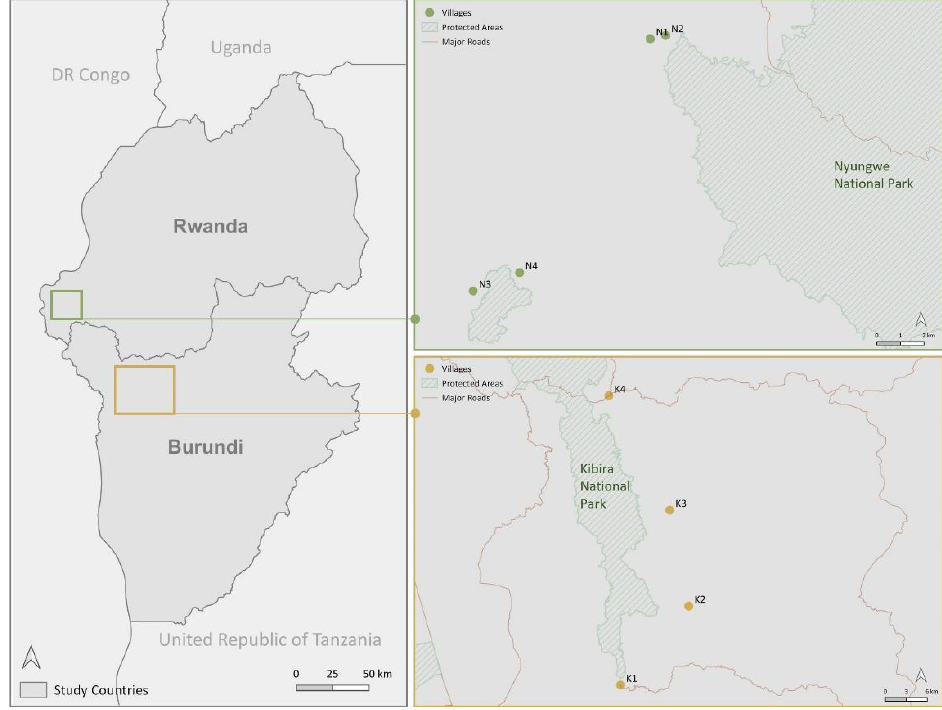
Figure 1. Study areas with the location of the villages